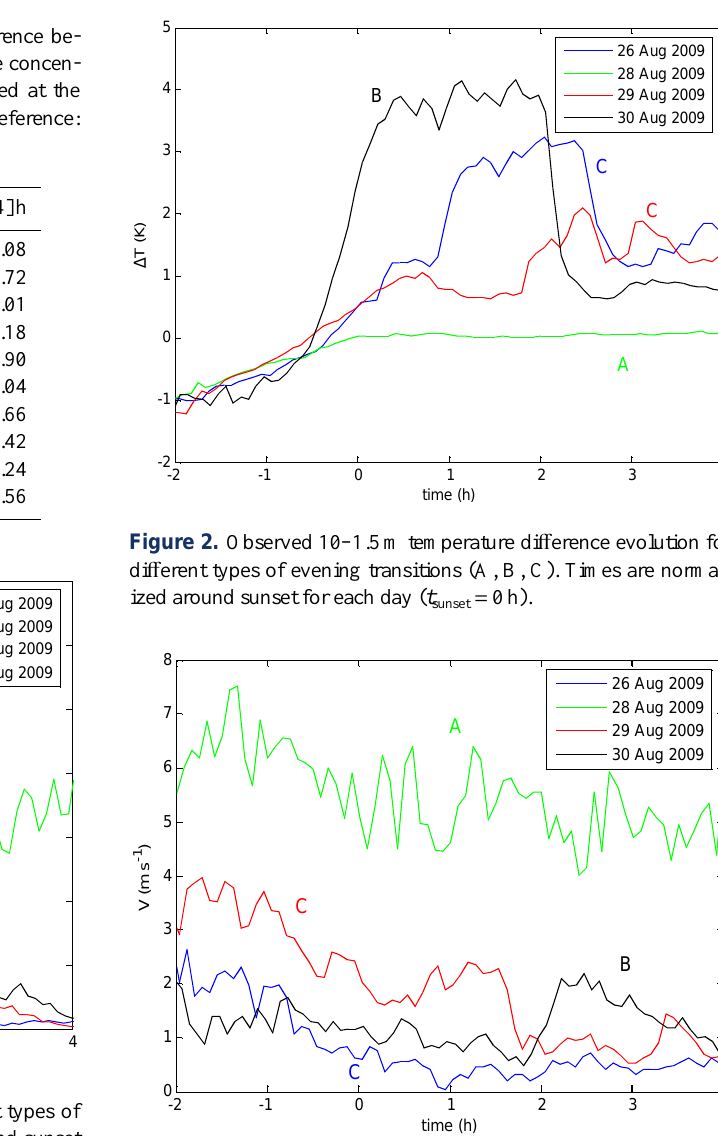
Figure 3. Observed 1.5m wind evolution for di ff erent types of evening transitions (A, B, C). Times are normalized around sunset for each day ( t sunset = 0h).